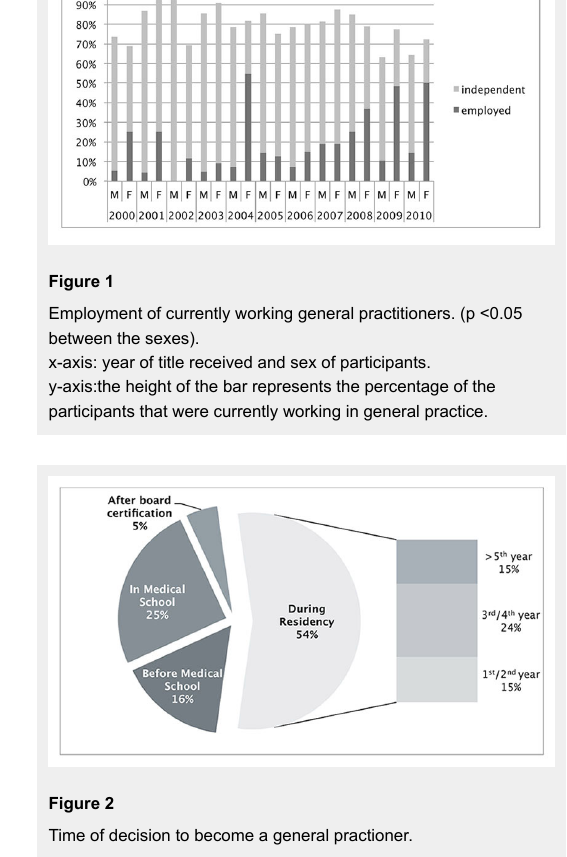
Time of decision to become a general